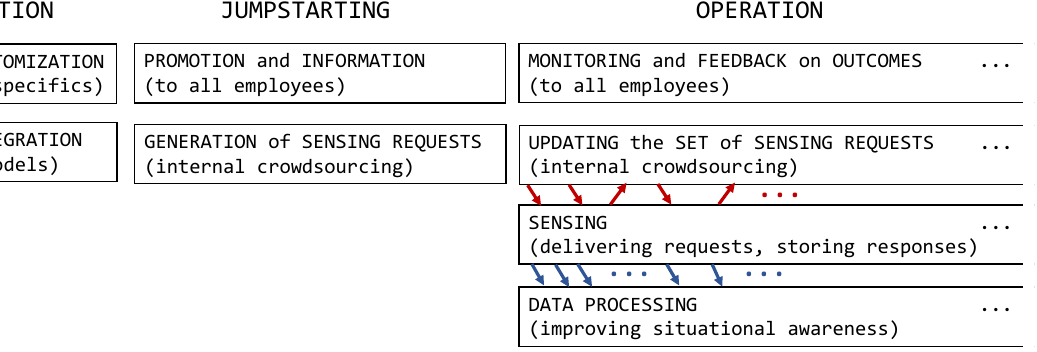
Figure 4. A possible ICC organizational process: three consecutive phases, each with concurrently running “threads.” The arrows represent adding or removing sensing requests and injecting responses to the context repository, respectively. Other inter-thread dependencies are not shown.